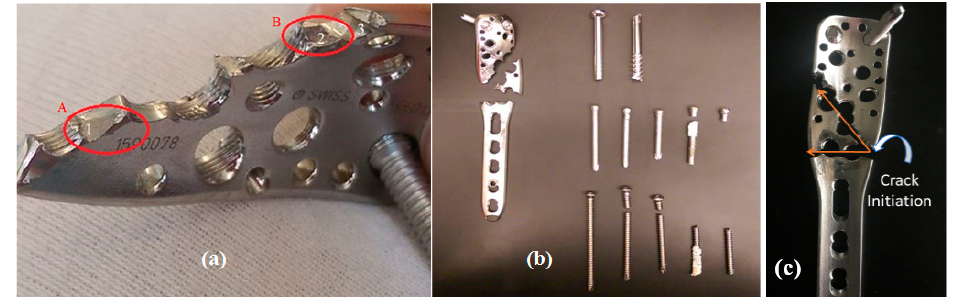
Figure 1. Submitted proximal humerus internal locking system (PHILOS) device for analysis; ( a ) plate through the thickness shows regions of interests marked by A and B and 1–3 investigated in this